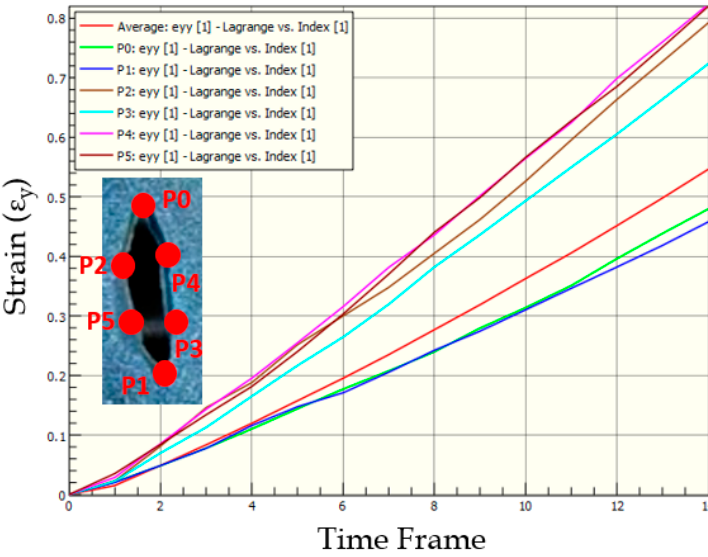
Figure 9. Average strain (y ‐ axis) versus time frame (x ‐ axis) measured using DIC from tensile test on the skin phantom specimen with symmetric ‐ short wound 1.